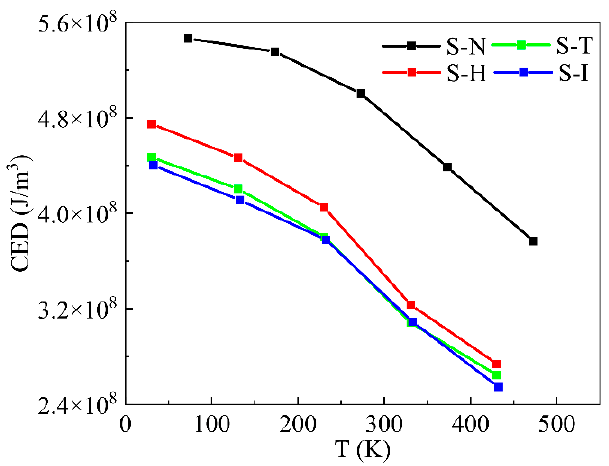
Figure 8. Cohesive energy density of IPN binder models at 73.15 K, 173.15 K, 273.15 K, 373.15 K and 473.15 K.